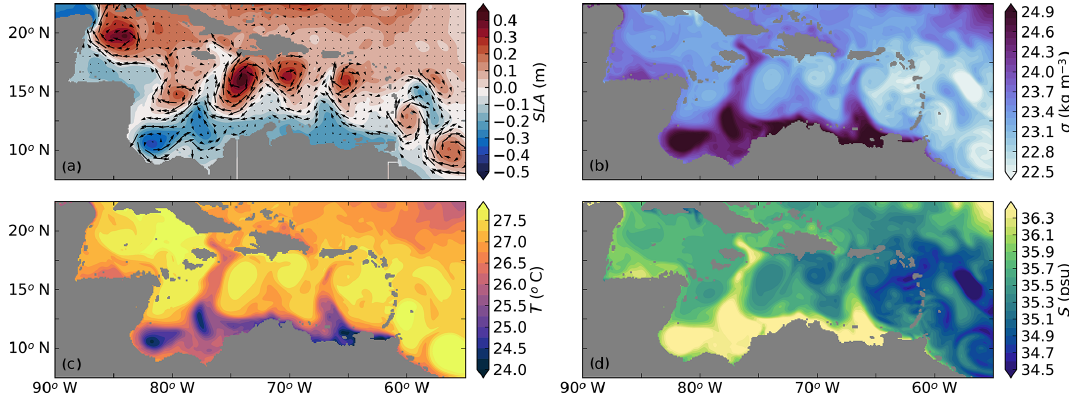
Figure 5. Near-surface properties of the Caribbean Sea averaged over a 5d period during the final year of the simulation Ekman100. (a) Mean sea-level anomaly (SLA, in meters) with velocity vectors. Surface current vectors are only shown every eighth grid cell for clarity purposes. (b) Density ( σ = ρ − 1000; kgm − 3 ), (c) temperature ( ◦ C), and (d) salinity (psu). Properties averages over the upper 50m. Table 1. Number of eddies per year and average Rossby number with standard deviations in each simulation between 12.5–17.5 ◦ N and 65–75 ◦ W. Amounts are obtained with the py-eddy tracker. The formation rate is computed as the number of eddies that are formed each year east of 75 ◦ W. The long tracks represents the percentage of the eddies that were formed east of 65 ◦ W and could be tracked west of 75 ◦ W. The Rossby number is calculated as Ro = u swirl /(R eddy ∗ f ) , where u swirl is the swirl velocity of the eddy, R eddy is the radius, and f the Coriolis parameter. Density, temperature, and salinity are taken at the core of the anticyclones; 1 standard deviation is added to indicate the interannual variability. Ekman50 Ekman75